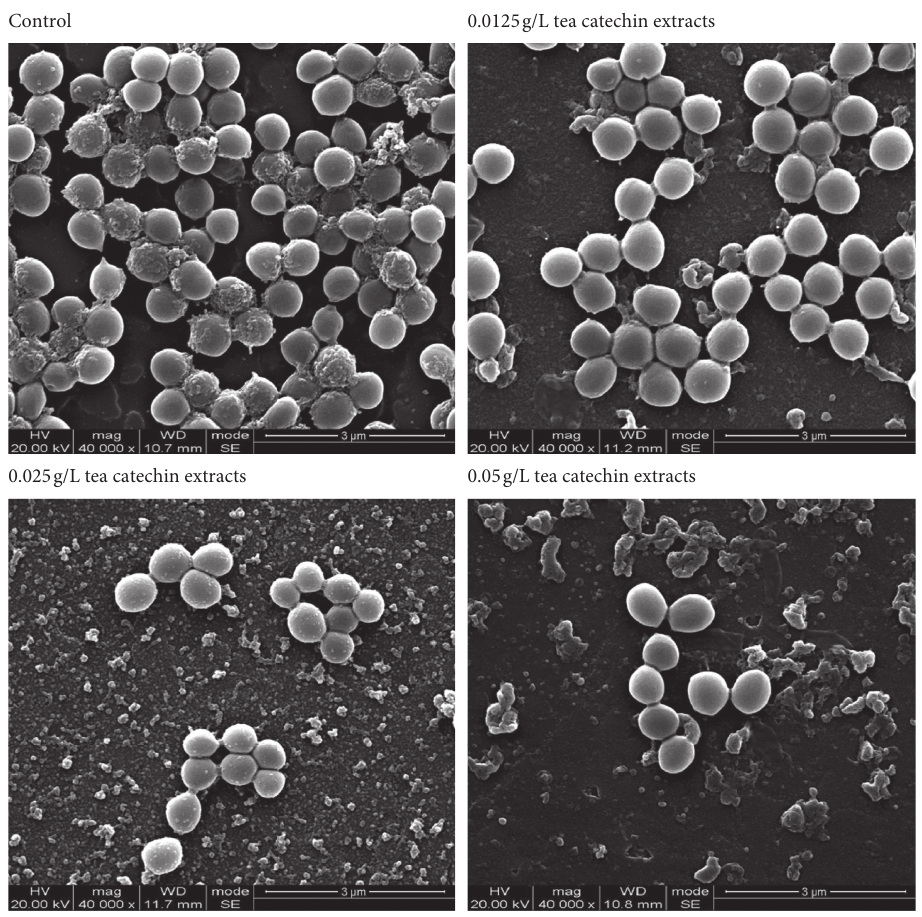
Figure 3: Scanning electron microscopy. MRSA strain 2 was cultured overnight in TSB broth containing 0.25% glucose supplemented with 0.05g/L, 0.025g/L, or 0.0125g/L tea catechin extracts at 37 ° C for 24hours, and the biofilm was fixed with 2.5% formaldehyde at 4 ° C for 2hours, dehydrated in increasing concentrations of ethanol, and examined using a scanning electron